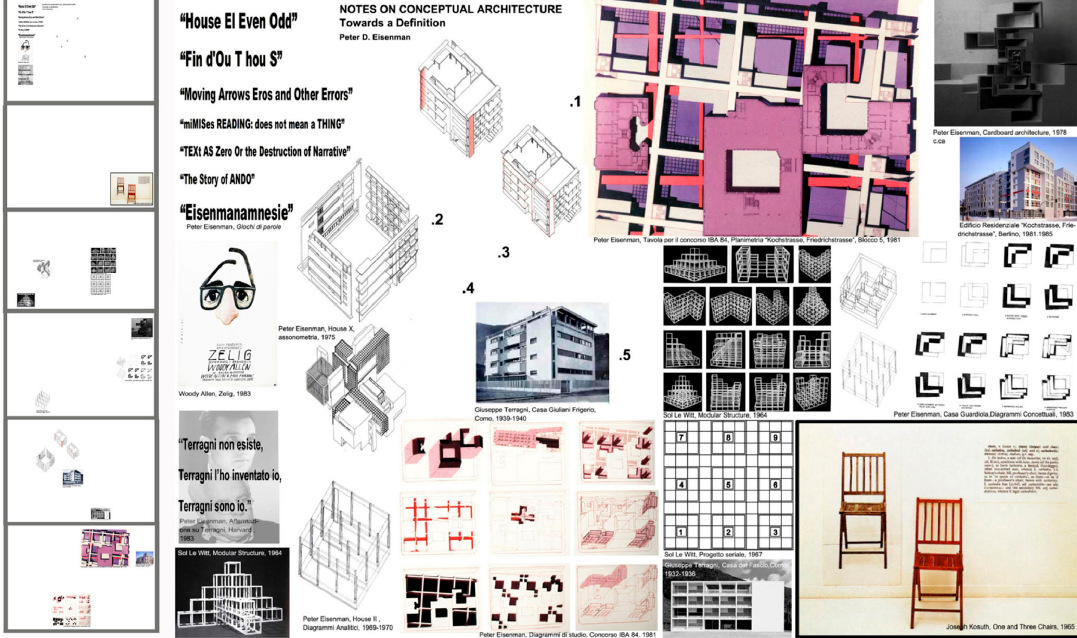
Figure 11. Giulia Bertola, Layering and synthetic interpretative plate of Eisenman’s competition entry for IBA